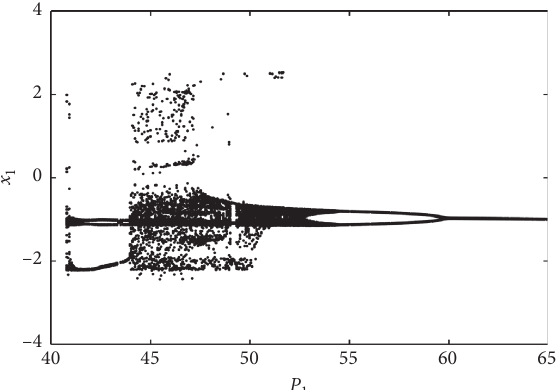
Figure 5: Bifurcation diagram for the first-order mode via external